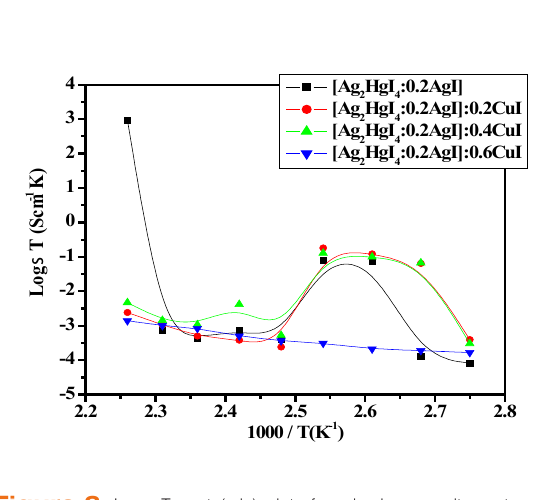
Figure 2. Log σ T vs. (1/T) plots for mixed composite systems, [Ag